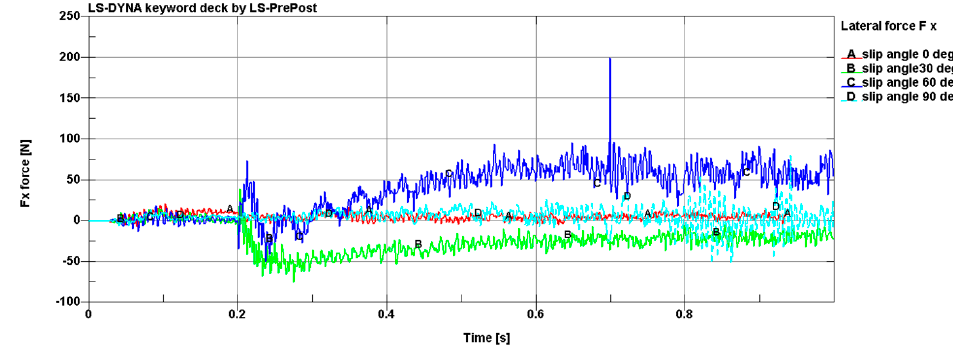
Figure 15. Lateral force distribution as a function of time for the range of slip angles.